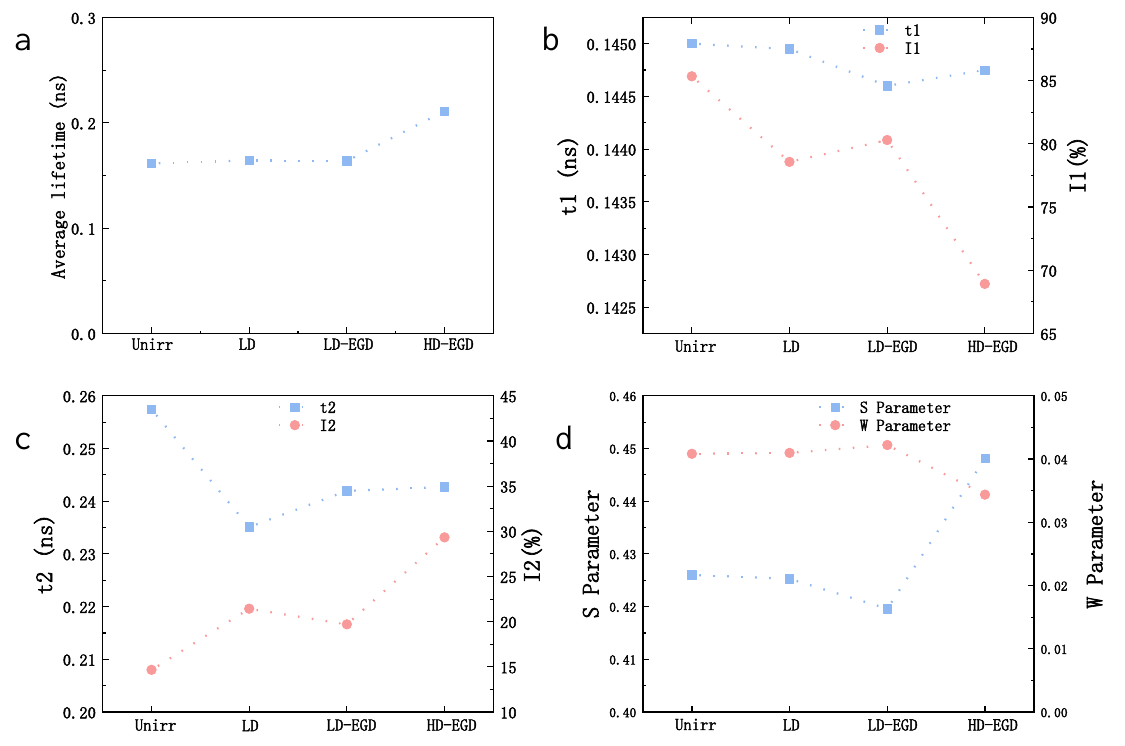
Figure 4. Positron annihilation test results of different irradiated samples: ( a ) the average lifetime, ( b ) the lifetime value and intensity of the first life component, ( c ) the lifetime value and intensity of the second life component, ( d ) the S parameter and W parameter of the Doppler broadened spec- trum.